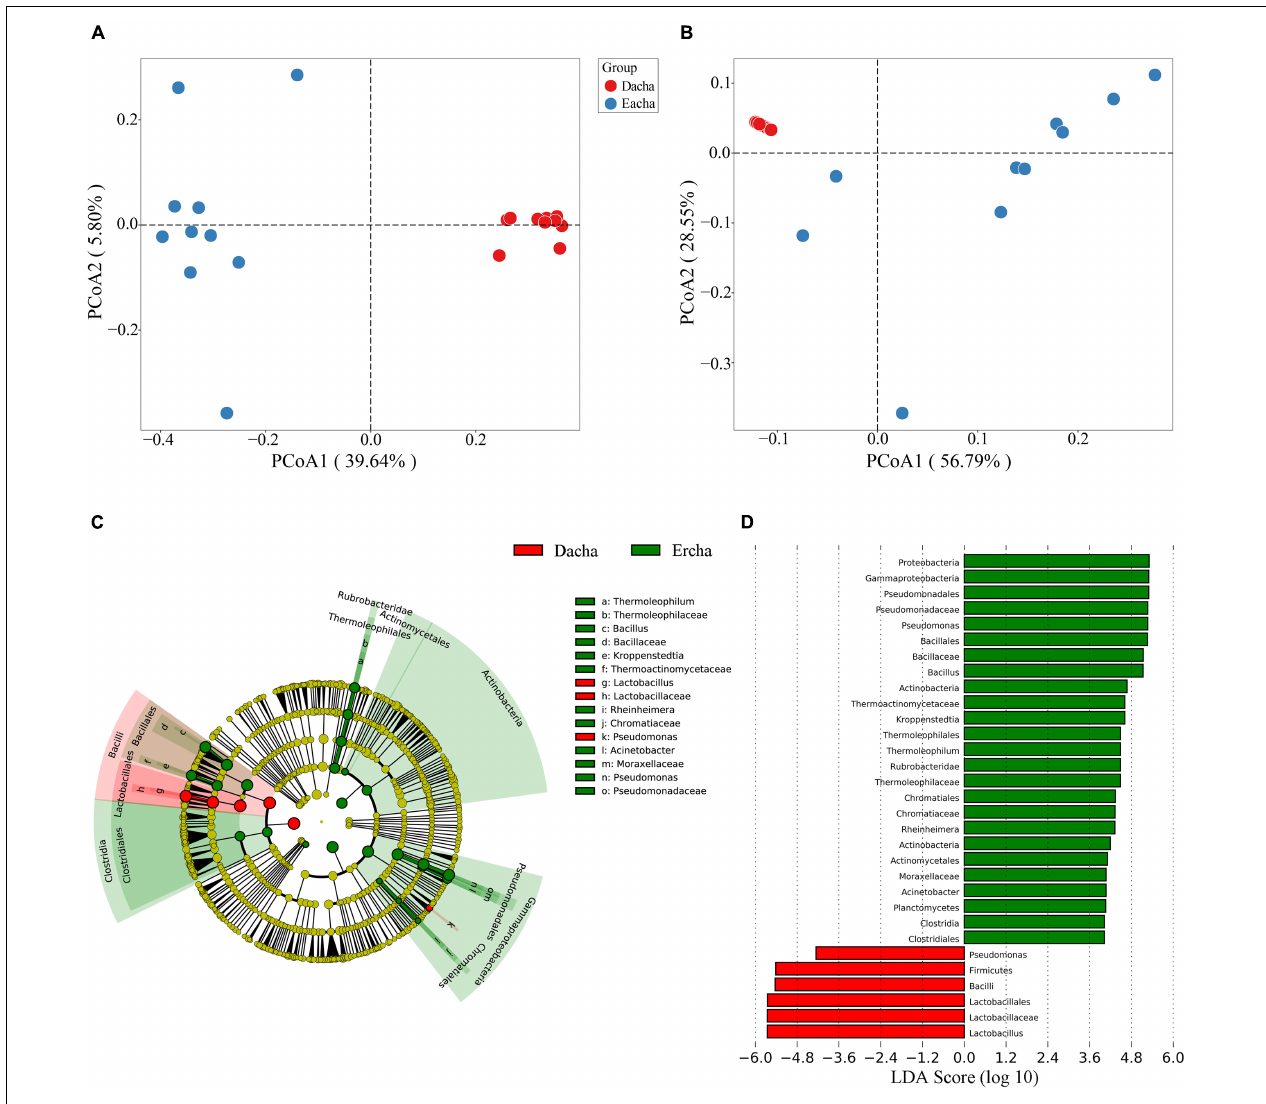
FIGURE 4 | PCoA based on unweighted (A) and weighted (B) UniFrac distance, LEfSe and LDA analysis indicating the cladogram (C) and LDA scores (D)